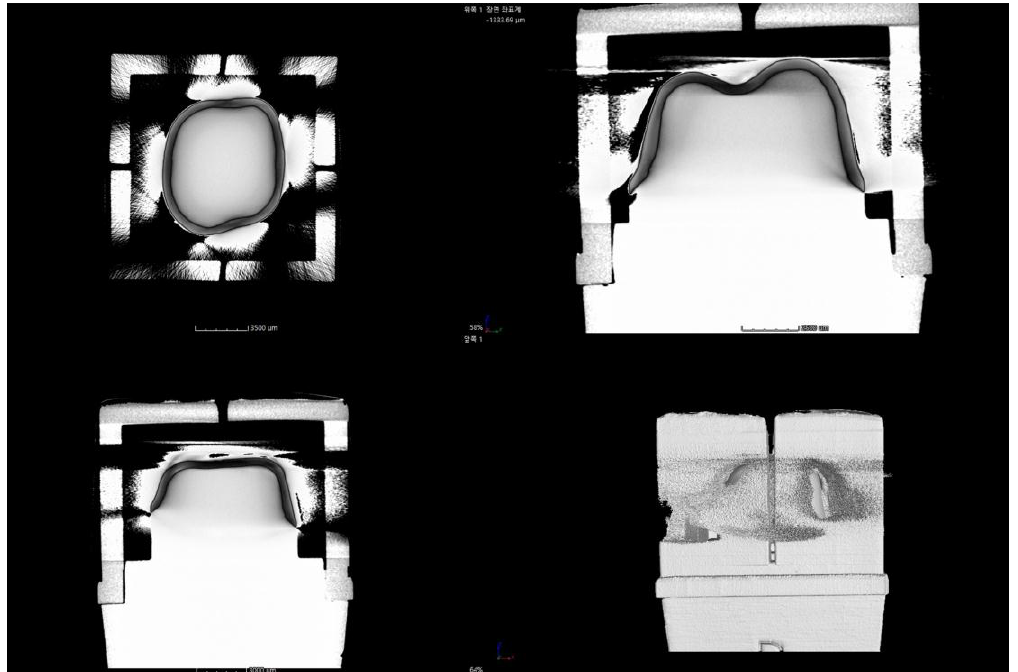
Figure 11. Image of the micro-computed tomography after cementation. Cross-sectional images show that marginal and internal gap measurements are not possible because the boundaries between the copings and abutments are uncertain.